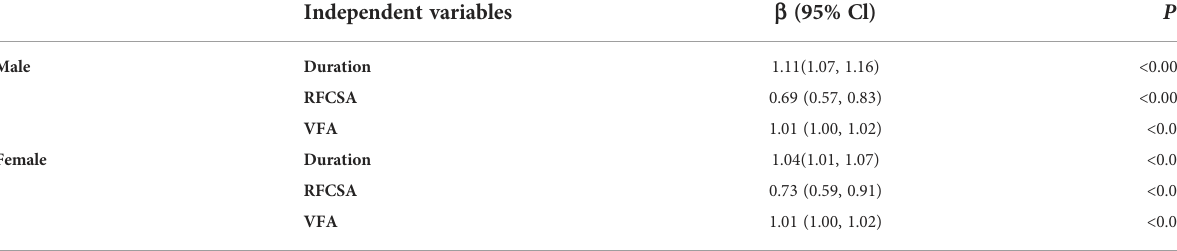
TABLE 4 Risk factors for high-/very high-risk prognosis of DKD in multivariate logistic regression.